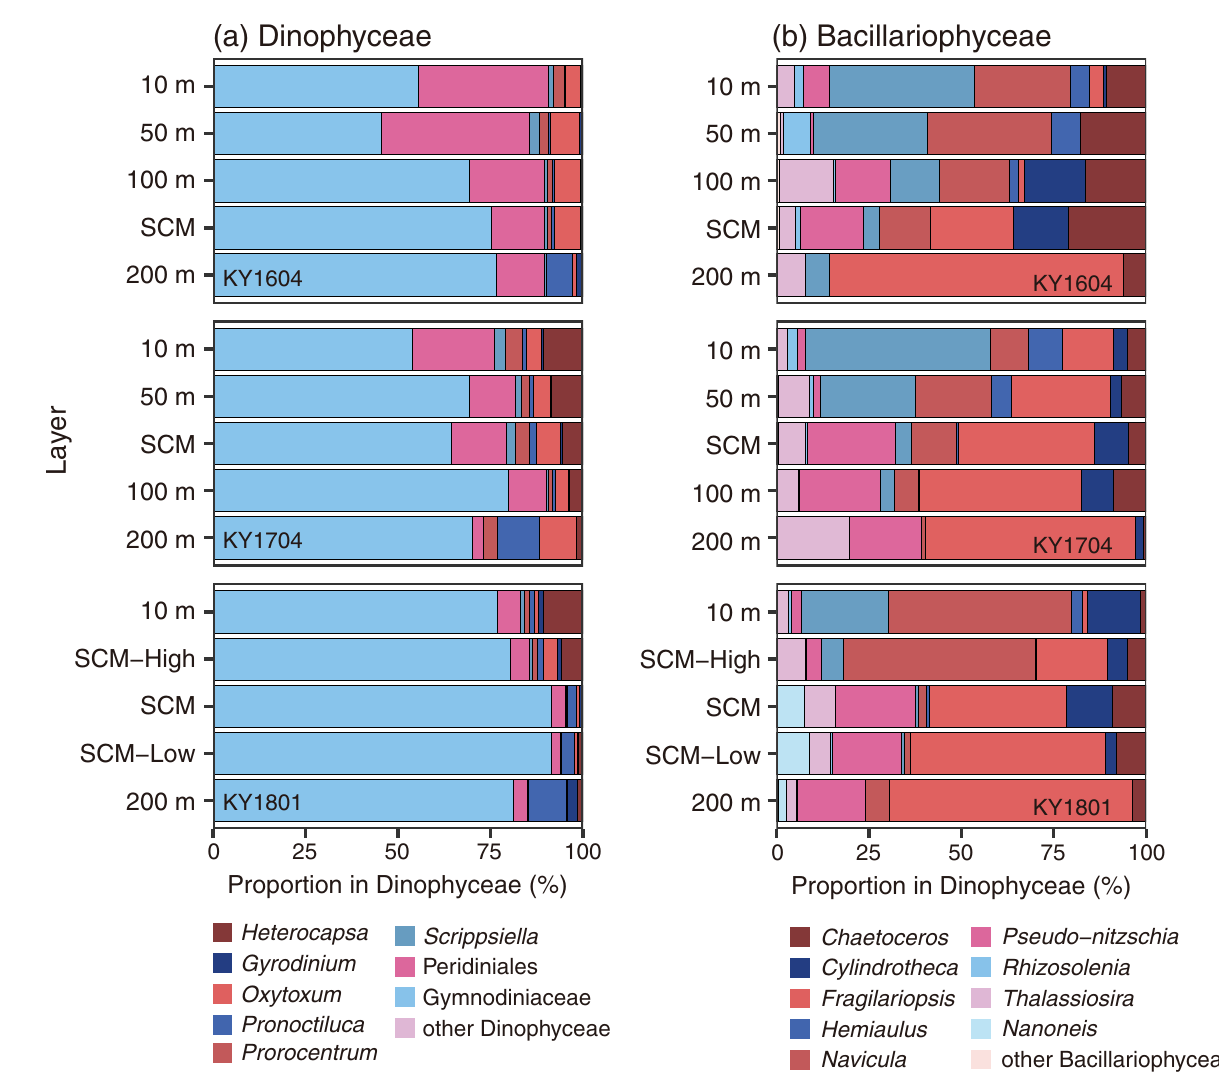
Fig 5. Vertical distribution of assemblages of (a) Dinophyceae and (b) Bacillariophyceae for KY1604 (top), KY1704 (middle), and KY1801 (bottom) cruises.